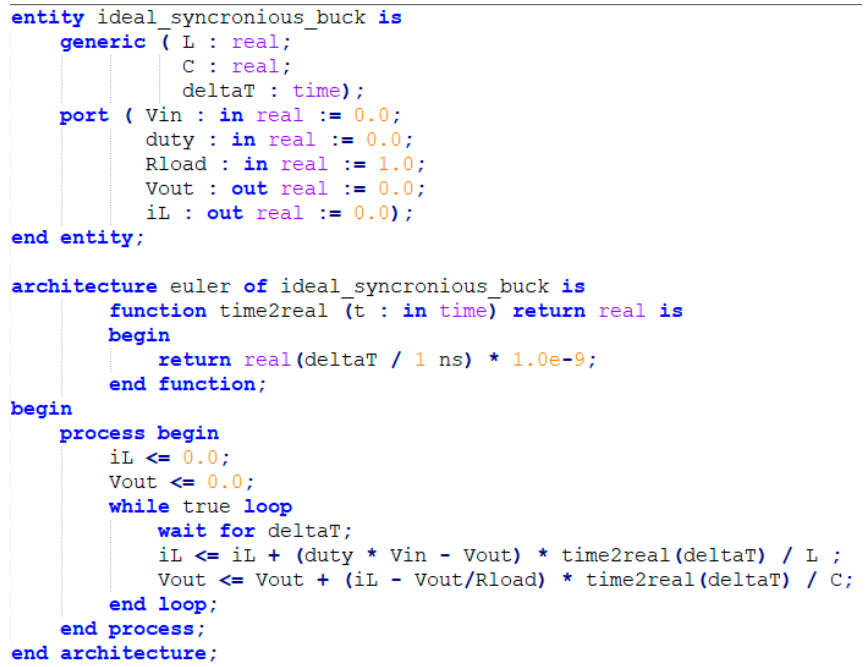
Figure A1. VHDL module of the ideal synchronous buck power stage.